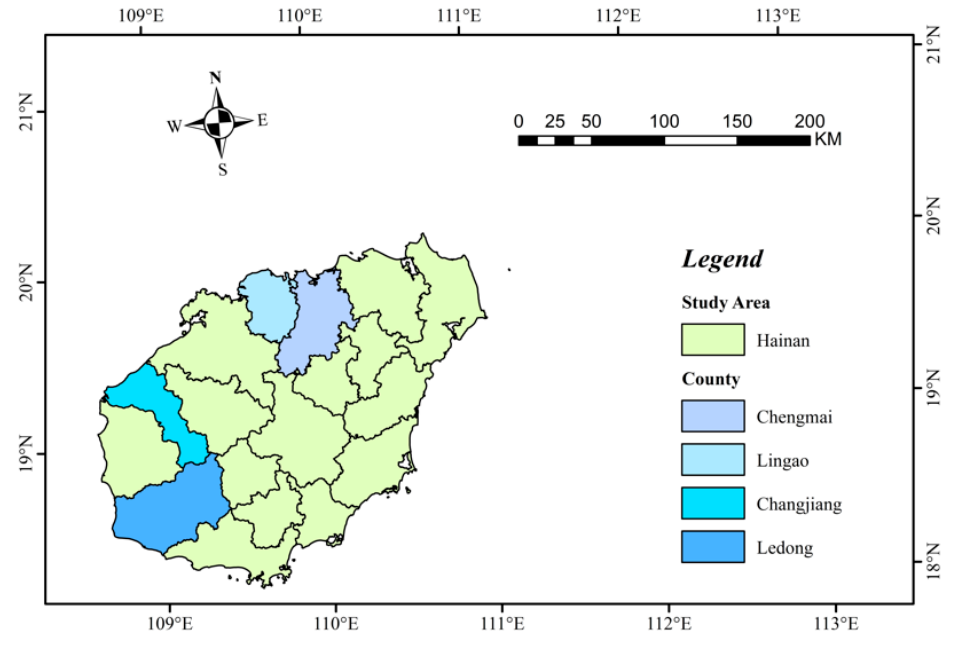
Figure 1. Map of study area. Table 2. Sample